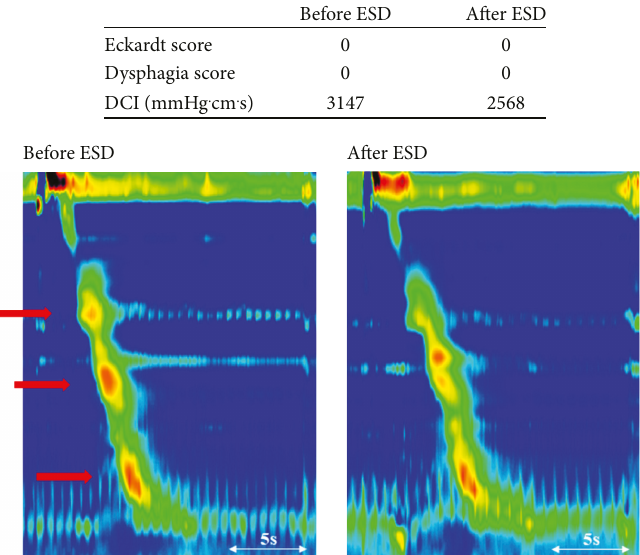
Figure 5: Representative case from group A in which no change was found after endoscopic submucosal dissection (ESD). Patient number 11 is a typical case from group A (less than 2/3 circumferential resection). Symptom score and distal contractile index (DCI) were not increased after ESD. Red arrows indicate physiological contractions: the fi rst, second, and third pressure trough,